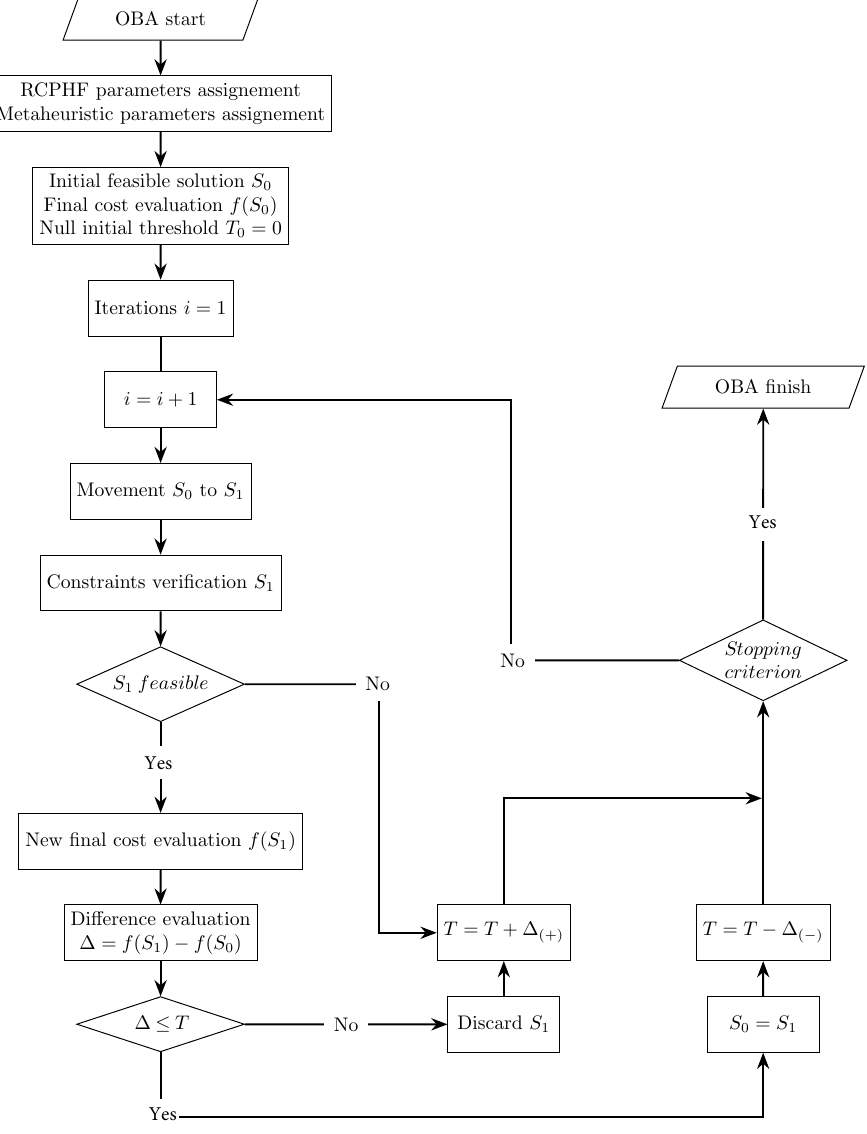
Figure 7. Flowchart of the old bachelor’s acceptance (OBA)